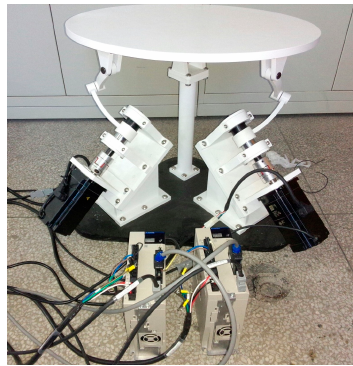
Figure 19. Field photo of the 2-DOF SPM prototype.